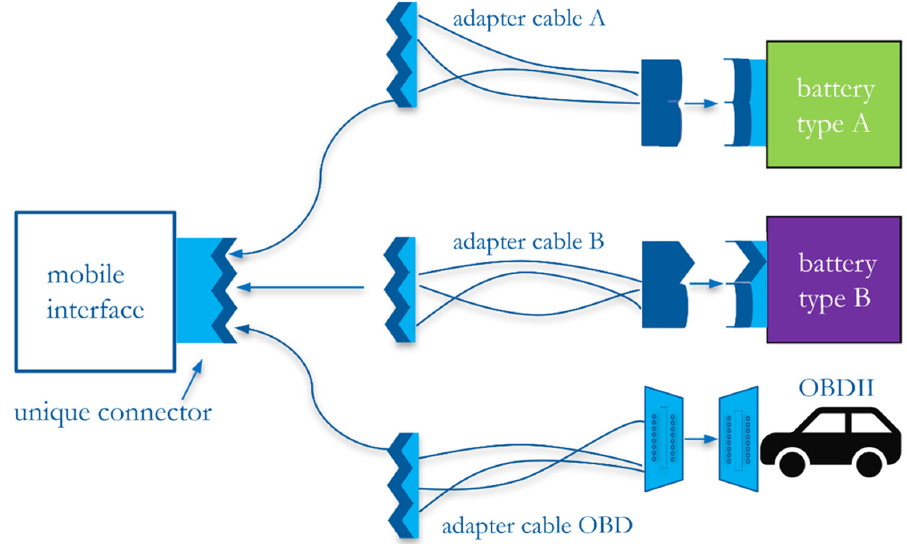
Figure 3. Mobile interface—concept of physical connection: with respective adapter cables, the mobile interface can be universally applied to a variety of battery models as well as directly connected to the OBDII port.